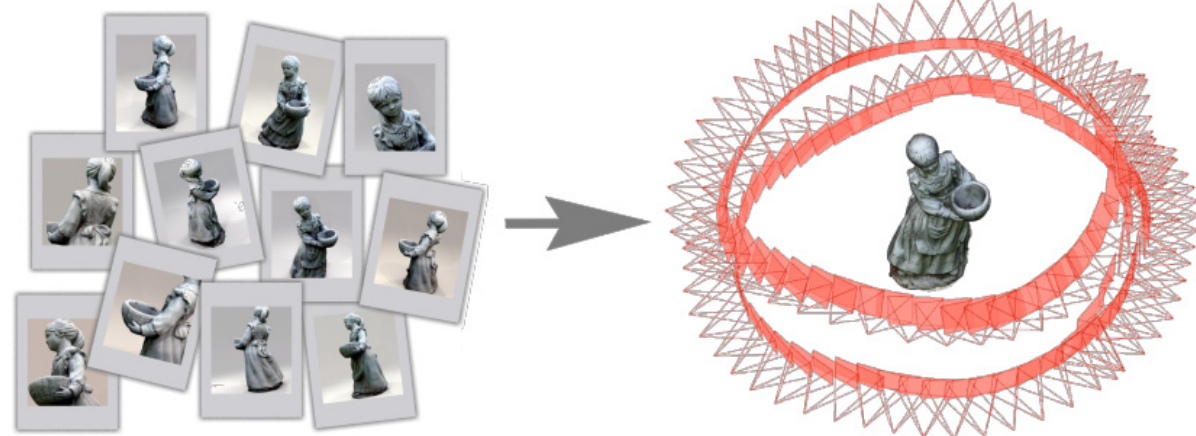
Figure 1. Workflow of three-dimensional reconstruction. Source: Bianco et al. [17]. In a simplified approach, given a set of images acquired from different observation points, the pipeline obtains the camera pose for each image and a three-dimensional reconstruction of the scene or object of interest in the form of a sparse point cloud (Figure 2).